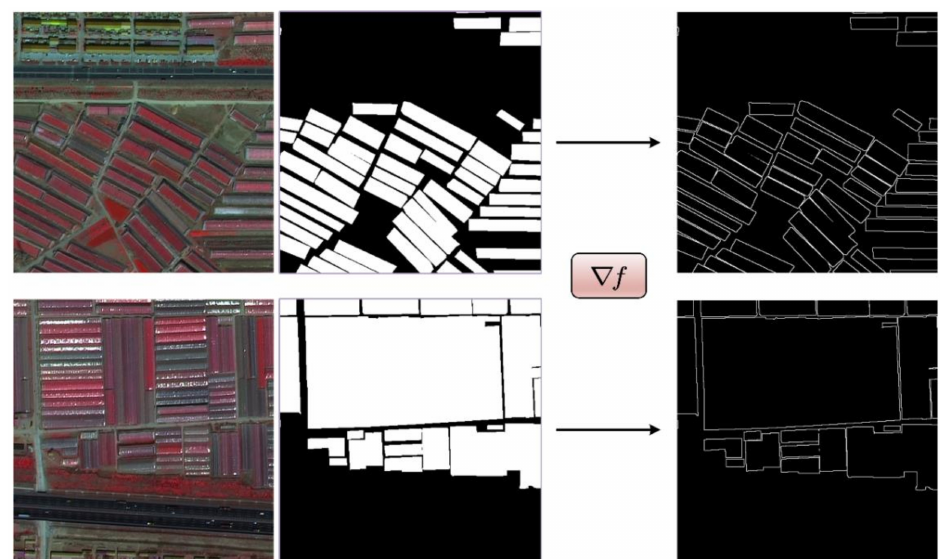
Figure 10. Typical visualization examples of segmentation masks and derived boundaries through Spatial Gradient Variation (SGV) unit (Column 1 represents the original images in false color com- posite and the ground truth and boundary are listed in column 2 and column 3,